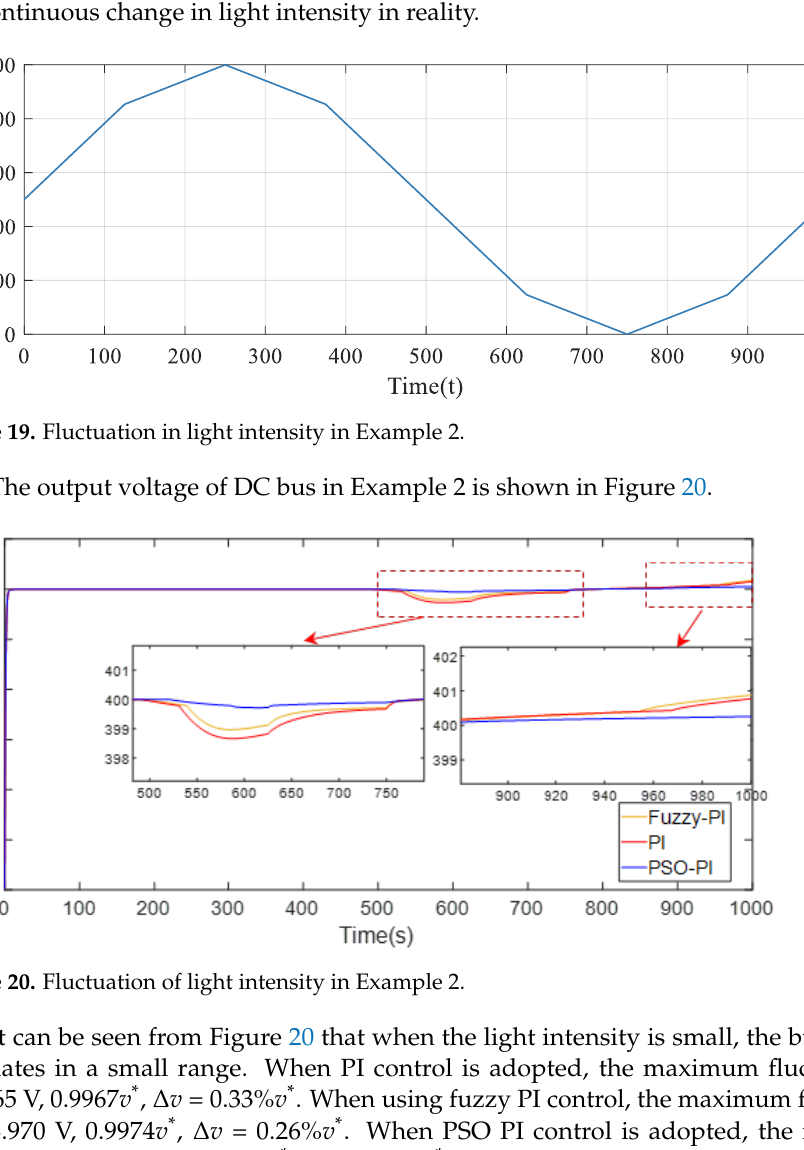
Figure 21. Bus voltage in Example 2 without AA-CAES. According to the comparison between Figures 20 and 21, when the light intensity is too low, the bus voltage of the DC microgrid system with AA-CAES fluctuates and can return to the rated voltage. After removing AA-CAES, the DC bus voltage fluctuates greatly and cannot return to the rated value. The output power of the two groups of photovoltaic power generation units in Ex- ample 2 is shown in Figure 22.